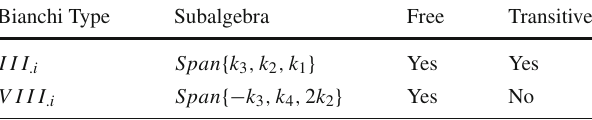
Table 1 Free and transitive actions of three-dimensional isometry Lie subgroups on the AdS 2 × S 1 Bianchi Type Subalgebra Free